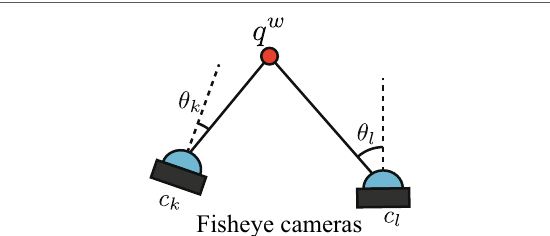
Fig. 7 Illustration of the incident angle. Camera c k has the smallest incident angle θ k and c l has the second smallest incident angle θ l . q w is a point of a model in the world coordinate